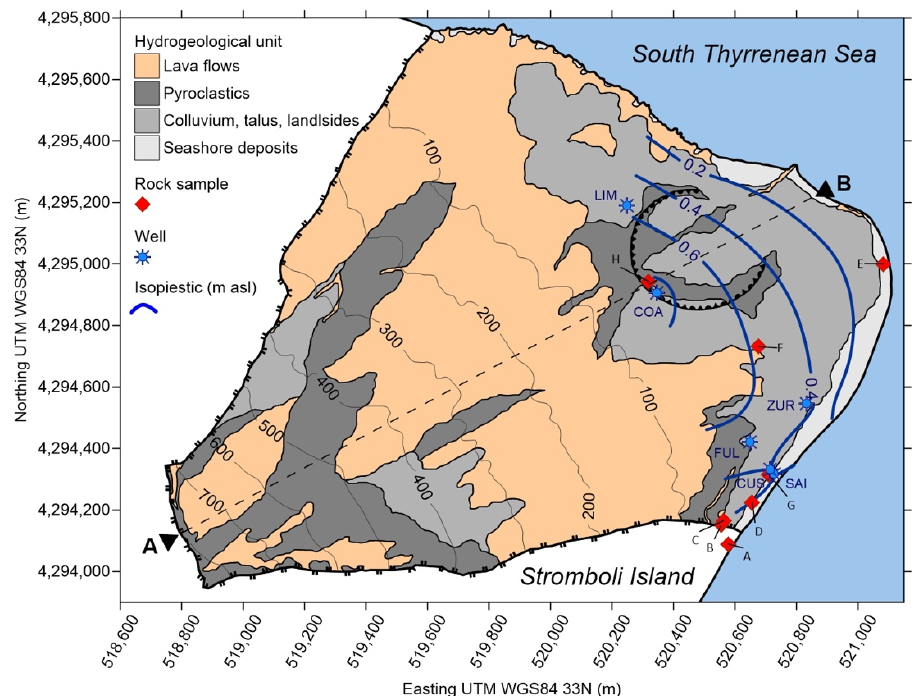
Figure 2. Detailed map of the studied area reporting the location of water wells and rock samples for the hydraulic conductivity determinations, main hydrogeological divide, limits of the hydrogeological units, and isopiestic lines (contour interval 0.2 m a.s.l.); elevations are in m a.s.l. The dashed line A–B indicates the trace of the hydrogeological section later discussed. Water table elevations (m a.s.l.) were calculated as the difference between the two Table 1. Values of hydraulic conductivity under saturated conditions (K sat ), normalized at 10 °C, measured in Stromboli samples (Figure 2 for locations). abovementioned parameters (Table 2; well locations in Figure 1). Table 2. Water table elevation (WTE, m a.s.l.) and physical and chemical parameters of the groundwater: pH, temperature